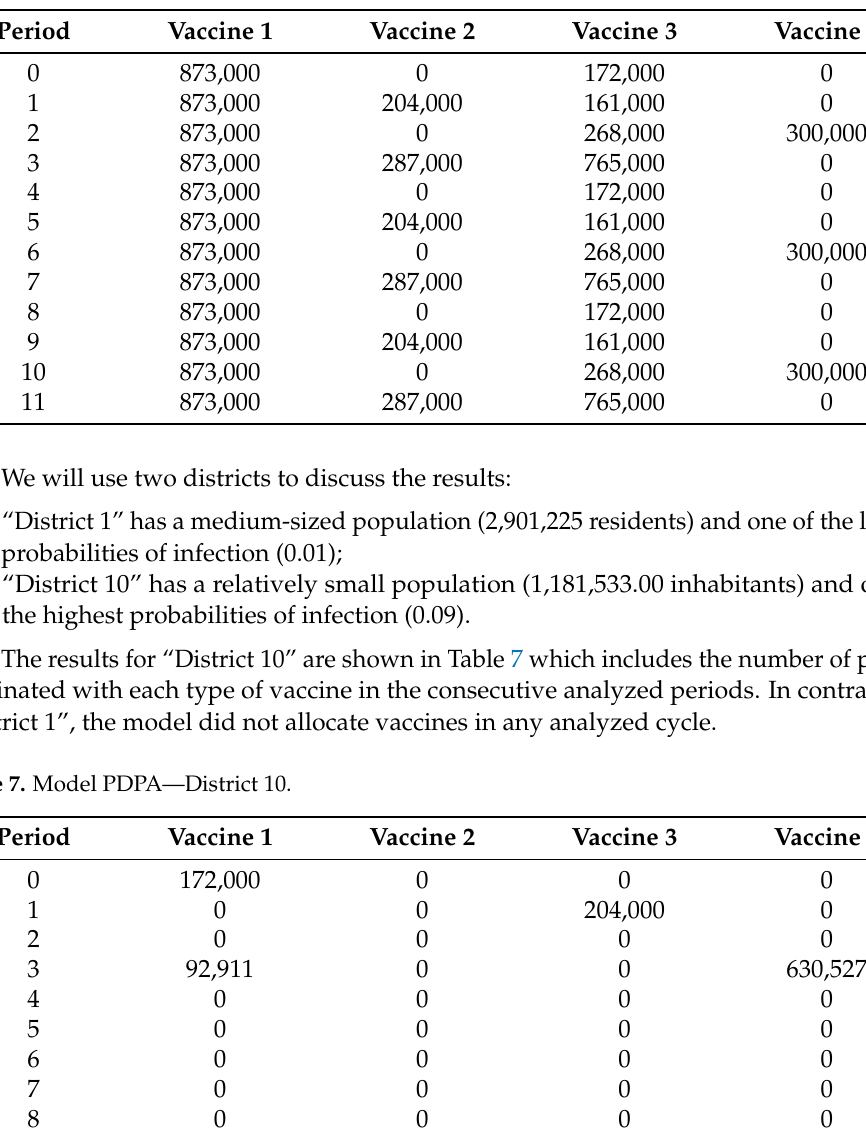
Table 6. Assumed schedule of vaccine delivery [the number of people who can be vaccinated].